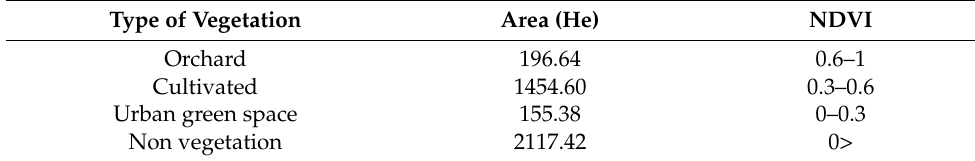
Table 3. Vegetation obtained from the